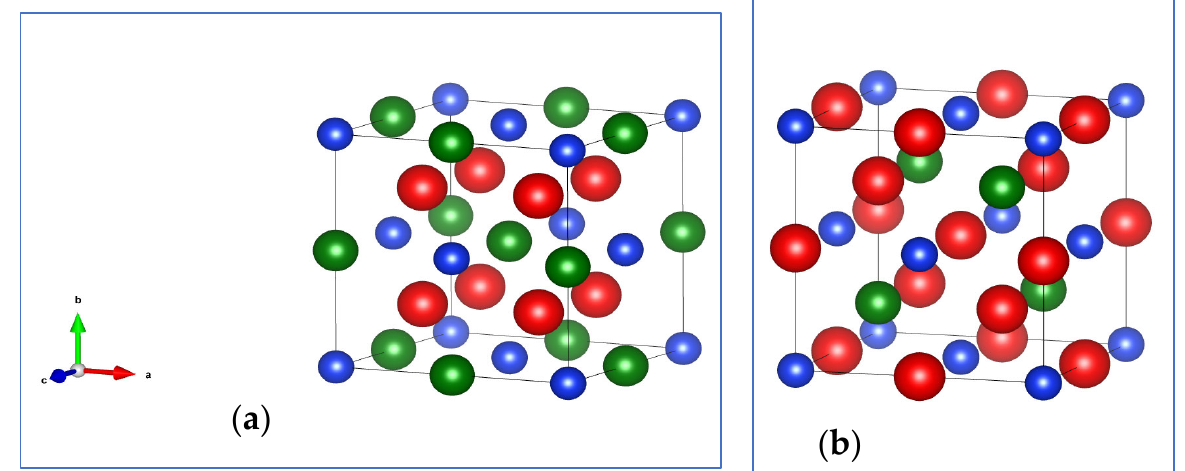
Figure 1. Crystal structures of Sc 2 TiAl and Sc 2 TiSi in ( a ) regular Heusler (L2 1 ) and ( b ) inverse Heusler (Xa) (Red: Sc, Green: Ti, Blue: Al/Si).